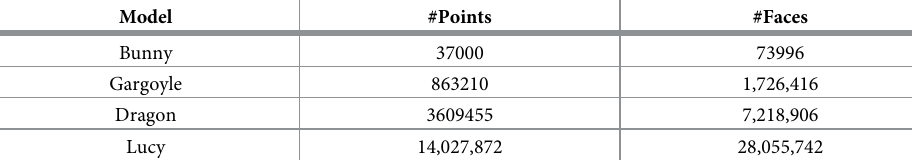
Table 1. The set of meshes used in our experiments.